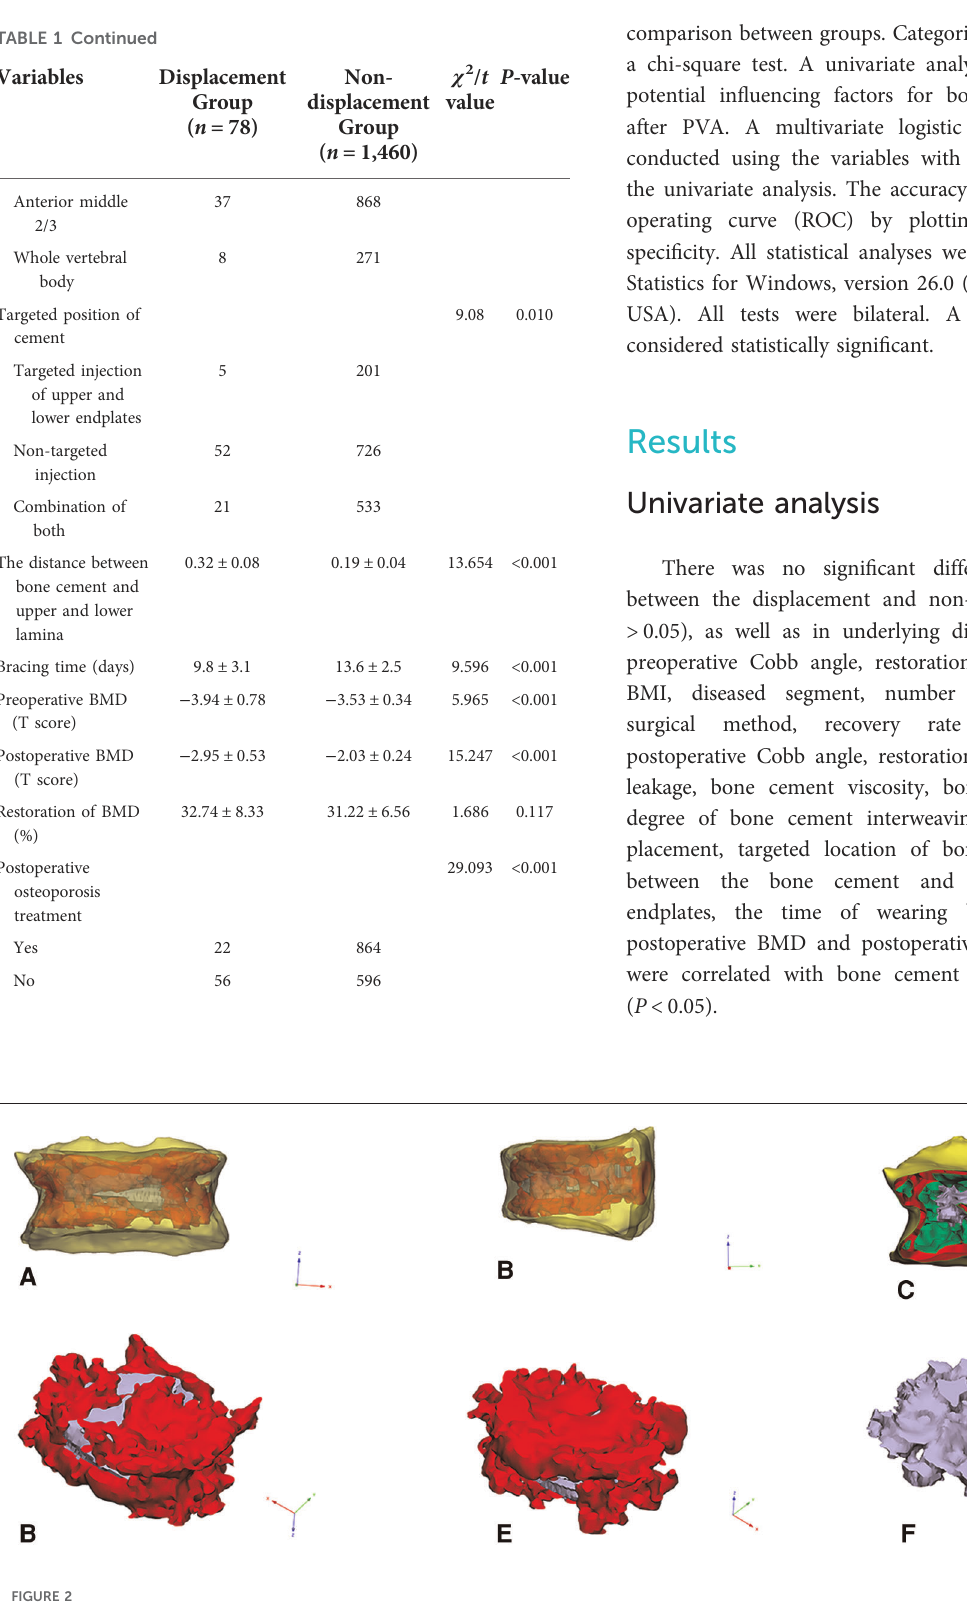
FIGURE 2 ( A – C ): The picture of the three-dimensional geometric model of the responsible vertebral body. ( D,E ): The picture of intravertebral bone cement model. ( F ): The picture of trabecular bone model in bone